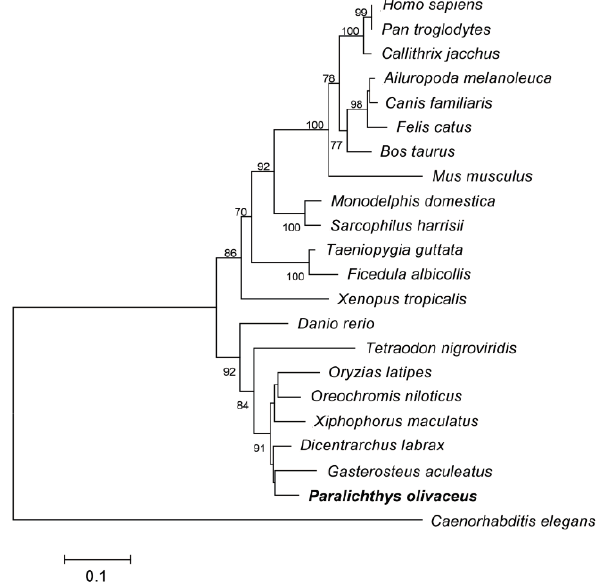
Figure 4. Phylogenetic analysis of Po -PRDM14 in comparison with PRDM14 or PRDM14-like proteins in other representative vertebrates based on their amino acid sequences. Po -PRDM14 is marked with bold fonts. The phylogenetic tree was constructed by MEGA from the Poisson correction distance via the neighbor-joining method with 1000 bootstrap replicates. The PRDM14 sequence of Caenorhabditis elegans served as the outgroup. The scale bar represents 0.1. The Ensembl IDs and accession numbers are as follows: Homo sapiens , Q9GZV8; Pan troglodytes , H2QWA1; Callithrix jacchus , F7I6N5; Ailyropoda melanoleuca , D2H9L4; Canis familiaris , E2QUL5; Felis catus , M3VWM4; Bos taurus , E1BCK6; Mus musculus , E9Q3T6; Monodelphis domestica , F6Y7L0; Sarcophilus harrisii , G3WS31; Taeniopygia guttata , H3CRY6; Ficedula albicollis , U3K0W4; Xenopus tropicalis , F6TMC6; Danio rerio , F1QWQ9; Tetraodon nigroviridis , F1QWQ9; Oryzias latipes , H2LVN9; Oreochromis niloticus , I3K9W9; Xiphophorus maculatus , M4A721; Dicentrarchus labrax , E6ZIN6; Gasterosteus aculeatus , G3NEF3; Paralichthys olivaceus , KM624610; Caenorhabditis elegans ,